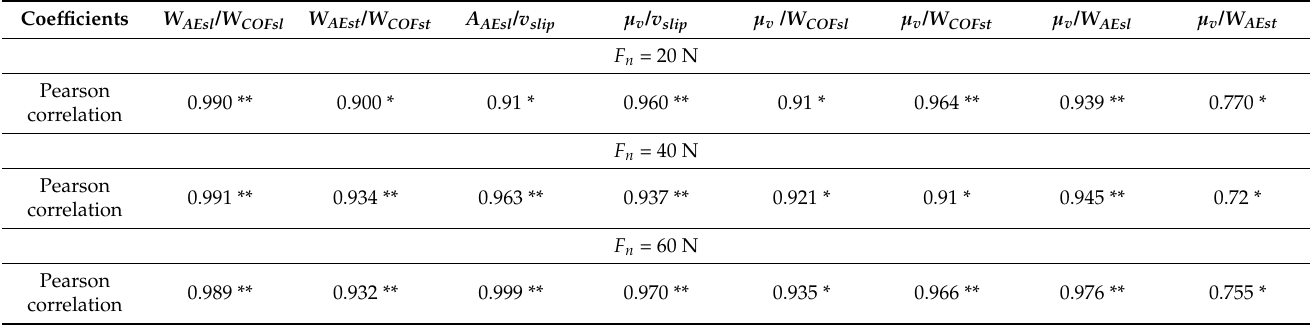
Table 4. Correlations between the AE and COF energies, stick–slip amplitudes and sliding speed in the stick and slip phases.